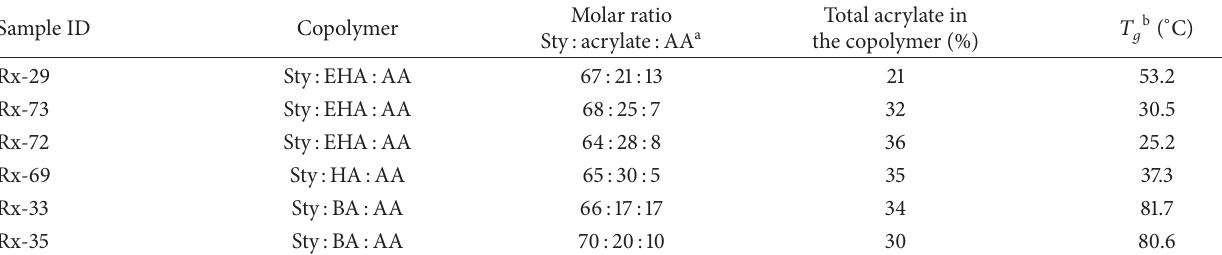
Table 2: Glass transition temperature ( 𝑇 𝑔 ) for prepared